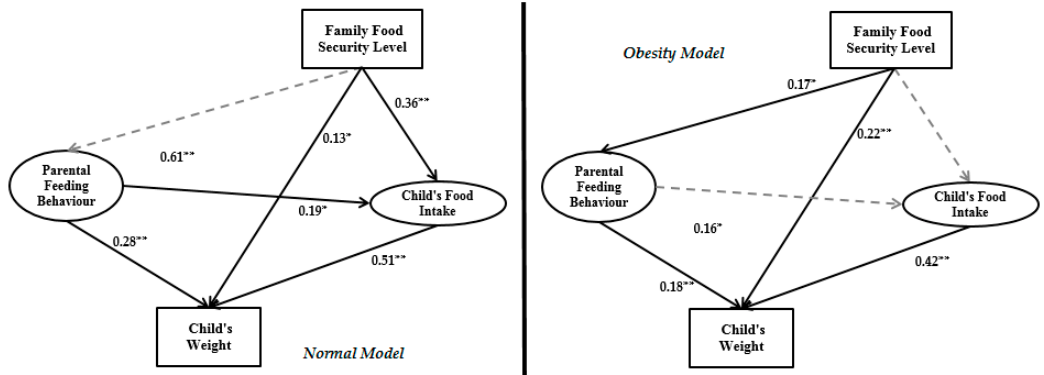
Figure 7. Impact of family food security level in the research framework for normal and obesity data (* Significant in the level of 5%; ** Significant in the level of 1%).